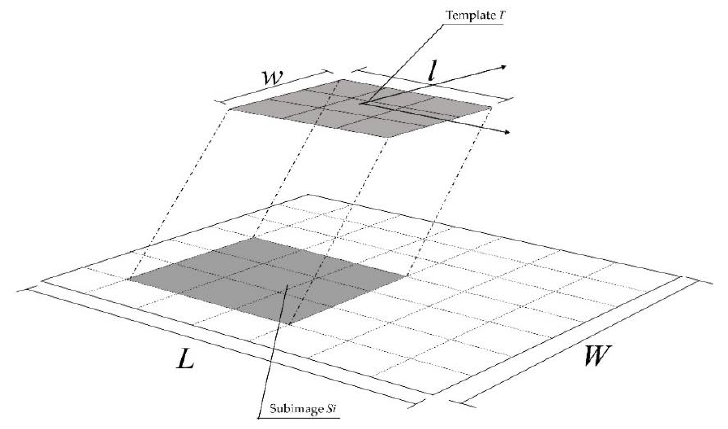
Figure 3. Schematic of template matching.